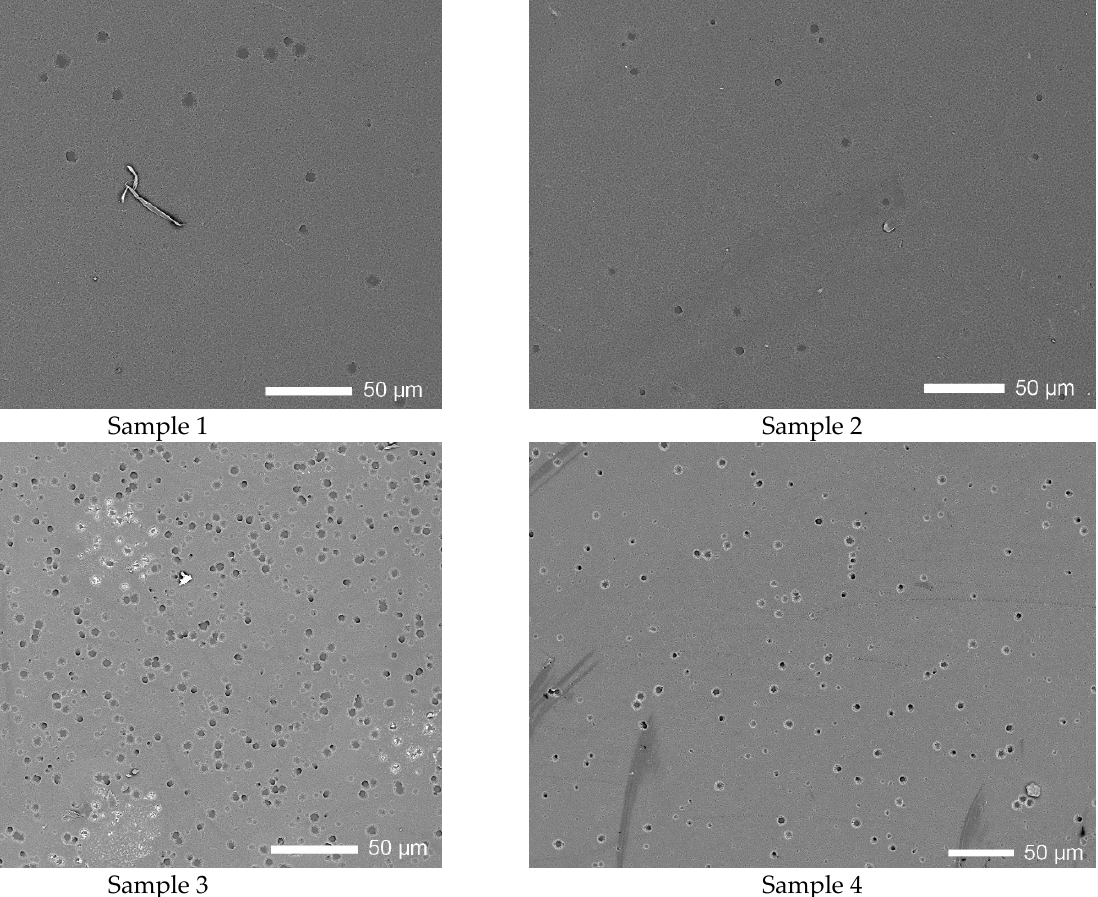
Figure 3. Surface morphology images of SSNTD films after chemical etching to visualize latent tracks.